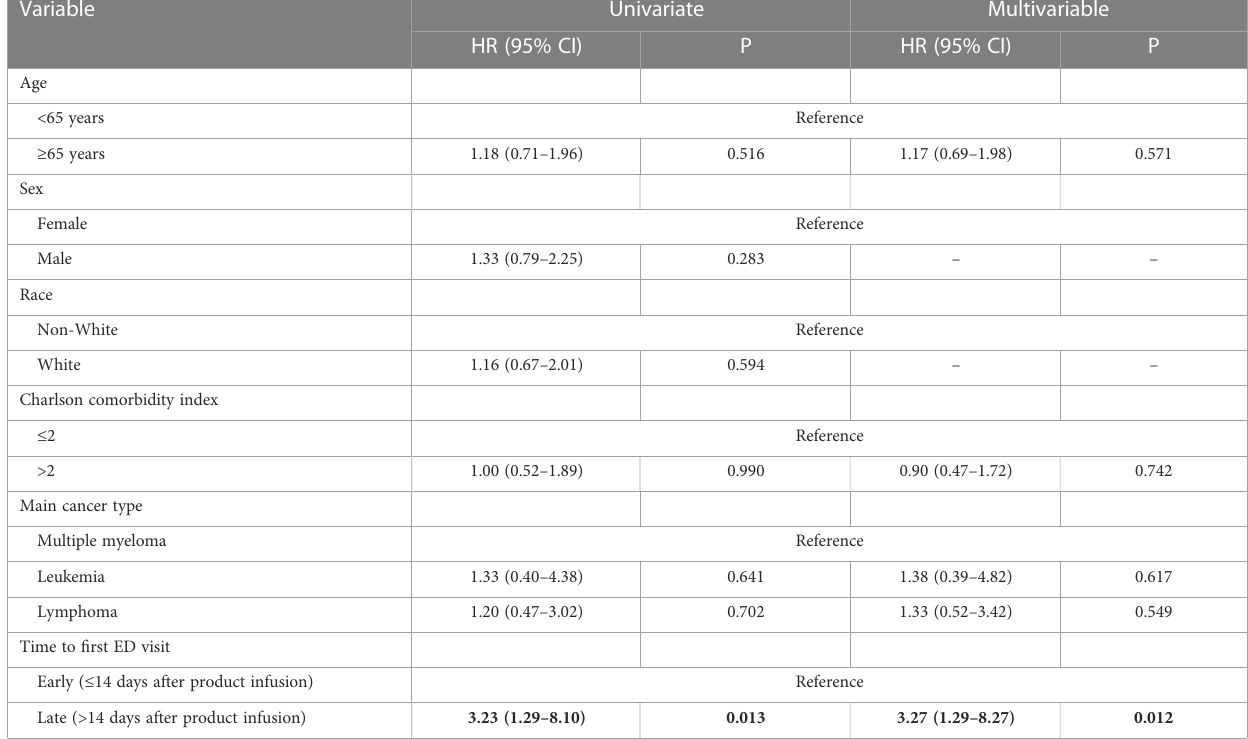
TABLE 4 Univariate and multivariable Cox proportional hazards analyses of overall survival in cancer patients who visited the emergency department within 6 months after CAR T product infusion (n = 168).